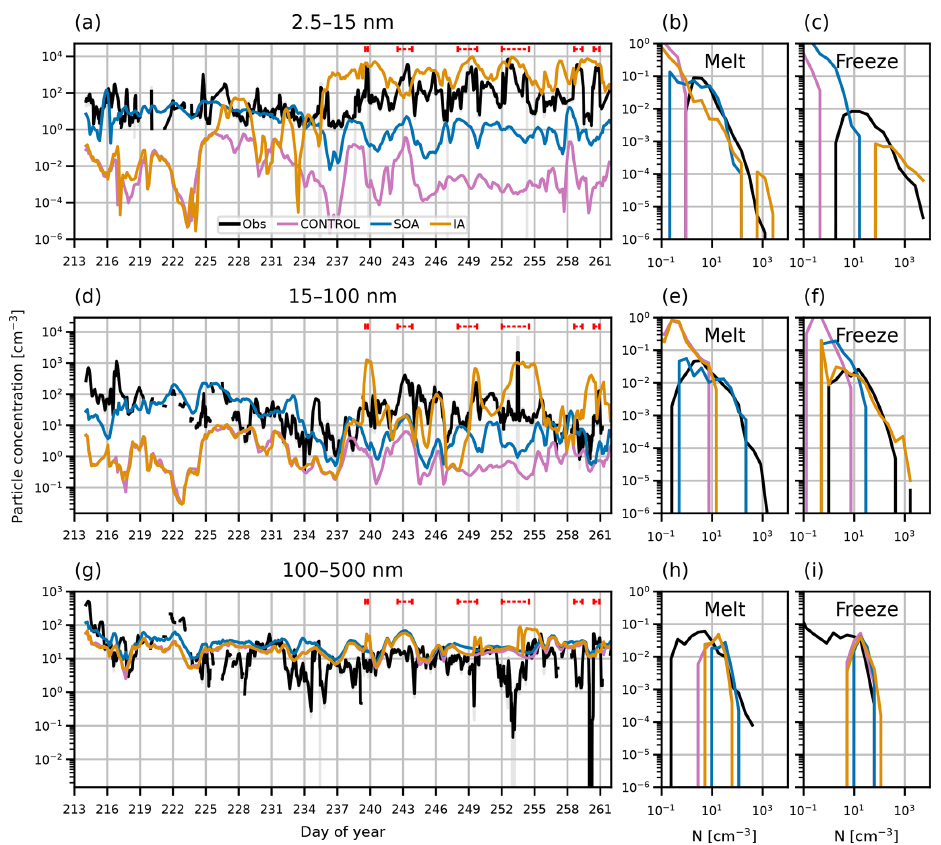
Figure 3. Time series and PDFs of surface aerosol concentration during AO2018 from observations and model simulations with various boundary layer NPF mechanisms. Model output is from simulations CONTROL (pink lines), SOA (blue lines), and IA (orange lines). Observations are shown as 3-hourly mean (black lines) and standard deviation (grey shading). Aerosol concentrations are shown for particles with diameter (a–c) 2.5–15nm, (d–f) 15–100nm, and (g–i) 100–500nm. Dashed red lines in (a) , (d) , and (g) show observed NPF events. PDFs are separated by the observed sea ice freeze-up date, 27 August 2018 (day